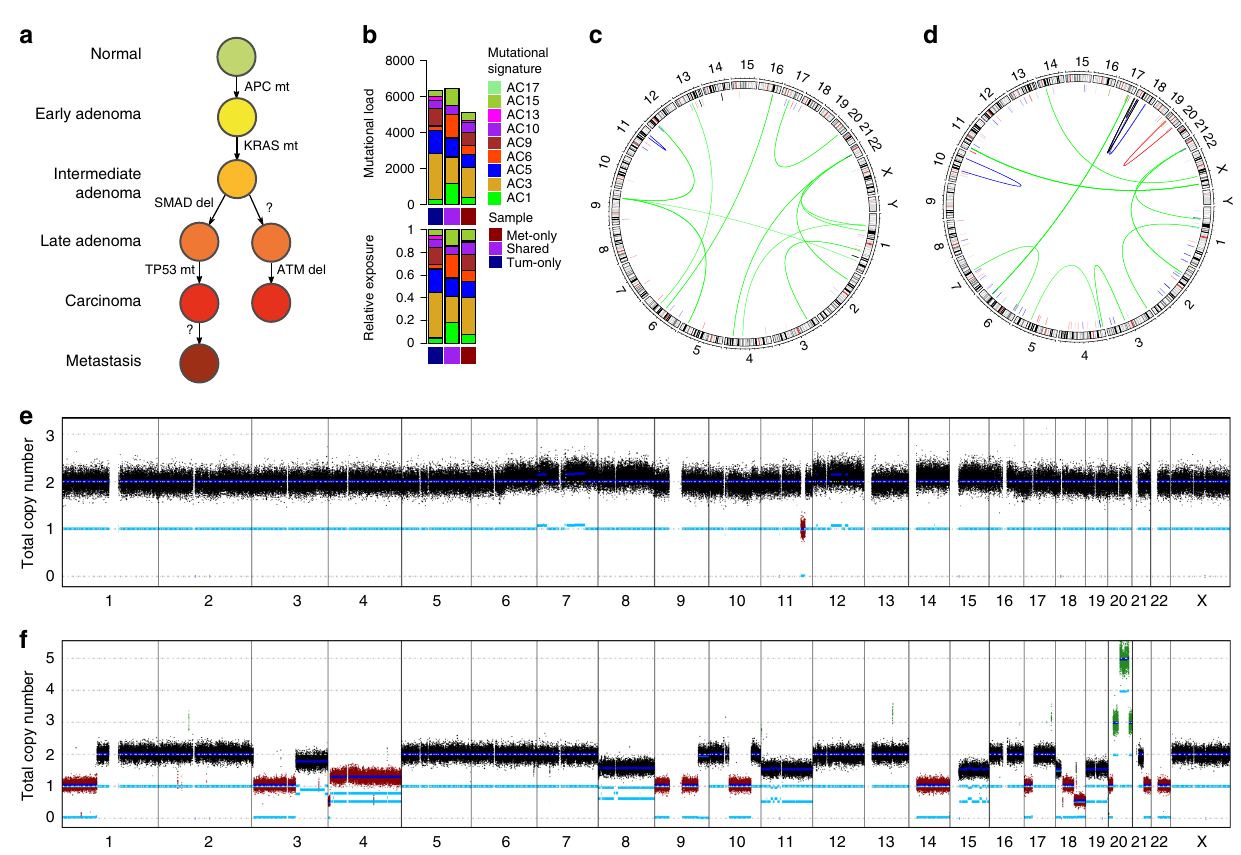
Fig. 5 Genomic landscape of tumor and metastasis mutations in patient CRC-010. Model of progression of tumor and metastasis from normal epithelial cells a , mutational signatures for tumor (dark blue), shared (red), and metastasis (dark red)-speci fi c mutations b , structural variations in tumor c and metastasis d and copy number pro fi les in tumor e and metastasis f . ATM is located in the small deleted segment of chromosome 11 in the tumor sample